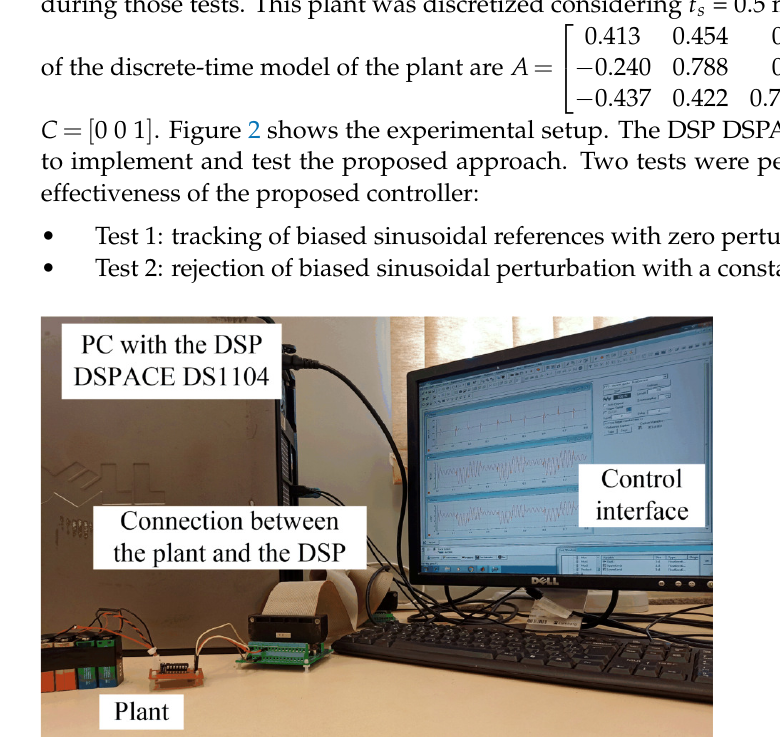
Figure 2. Experimental setup.